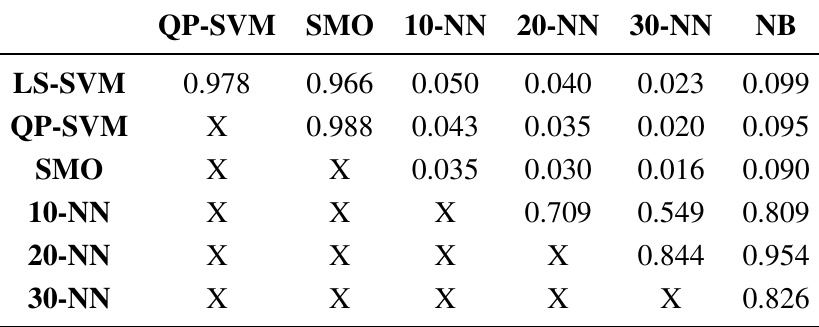
Table 2. Significance difference in FPR between